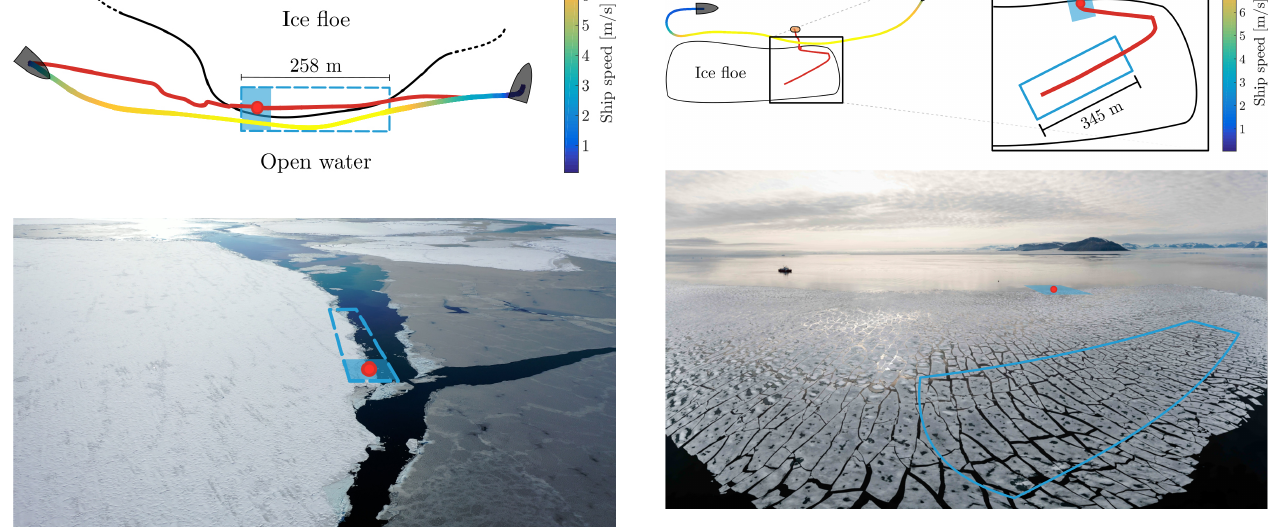
Figure 2. Schematic representation of the NBB experiment. The grey shape represents the ship, and the orange ellipse is the Zo- diac. The red and blue-to-yellow lines are the UAV and ship GPS tracks, respectively. The solid and filled blue rectangles are the area of the panoramic picture selected for analysis (Fig. 8) and the FOV of the drone when the breakup was recorded, respectively. The ap- proximate shape of the ice floe is also shown. The bottom image is an overview of the CCGS Amundsen and the selected floe after